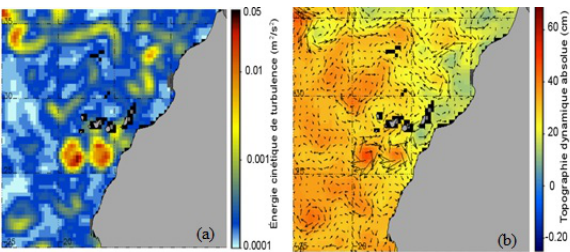
Figure 11. a: Eddy Kinetic Energy derived from AVISO data, b: Overlapping of sea surface height and derived geostrophic velocity